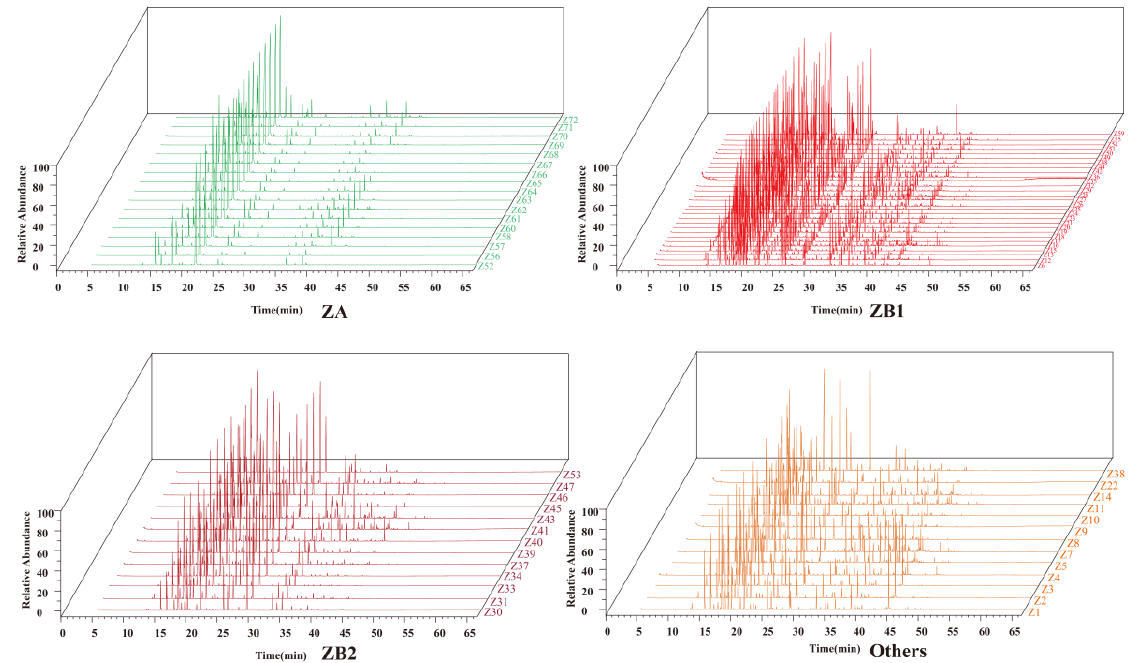
Figure 1. The volatile oil profile in different prickly ash pericarps. ZA, samples with green pericarps ( n = 17) derived from species of Z. armatum ; ZB1, samples with red pericarps represented by Hancheng ( n = 29) derived from species of Z. bungeanum ; ZB2, samples with red pericarps represented by Fengxian ( n = 13) derived from species of Z. bungeanum ; Others, samples with red pericarps, a clade of several species ( n = 13), not derived from species of Z. bungeanum .